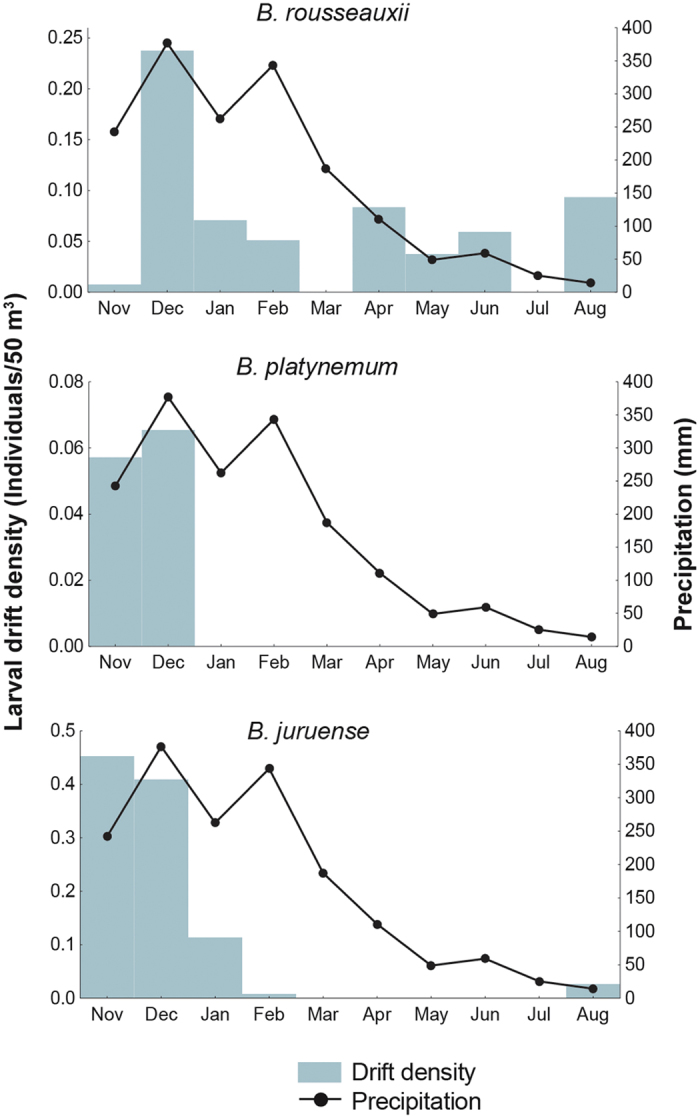
Goliath catfish larvae densities based on standardized sampling as indicators of spawning periods.The monthly drifting larvae densities of goliath catfishes in the Madre de Dios River of the upper Madeira Basin in relation to total monthly precipitation (mm) levels. Larvae densities were estimated based on ichthyoplankton samples from the Madre de Dios River between November 2004 and August 2005. Precipitation data were used as a proxy for river level since data for the latter were not available. Precipitation data are for the city of Puerto Maldonado were supplied by the Servicio Nacional de Meteorología e Hidrología del Peru (SENAMHI).